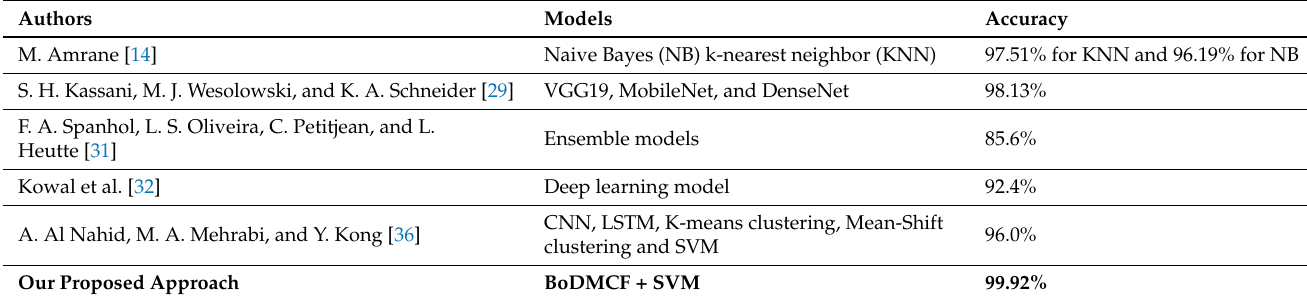
Table 12. Accuracy achieved by prior breast cancer binary classification work are also shown in the bottom